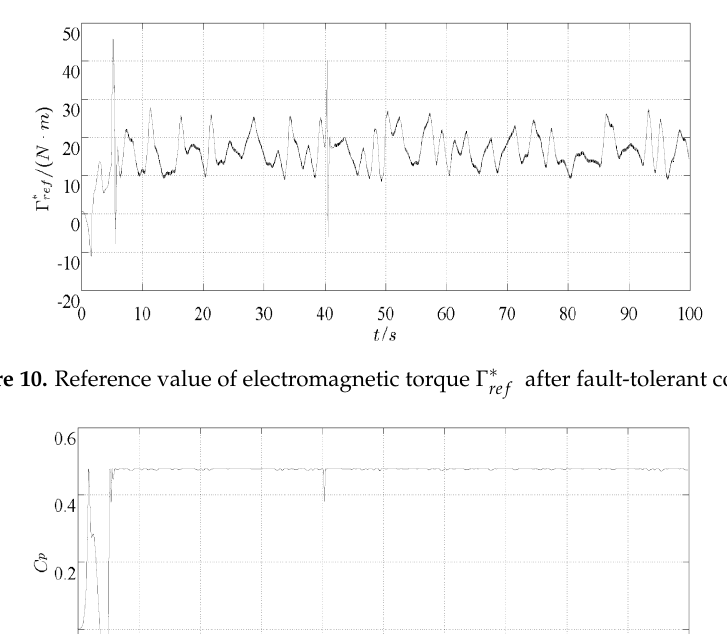
𝑟𝑒𝑓∗ when actuator fails